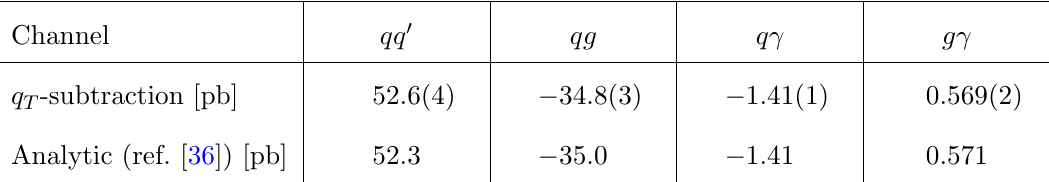
Table 1 . The O ( (cid:11) s (cid:11) ) contribution to the inclusive on-shell Z production cross section for the dif- ferent partonic channels. The results obtained using q T -subtraction are compared to the inclusive predictions obtained in ref. [36]. Numerical uncertainties on the last digit are indicated in paren- thesis for our predictions, while the uncertainties of the inclusive implementation are below the last digits shown. The category denoted by qq 0 includes all combinations of quarks and